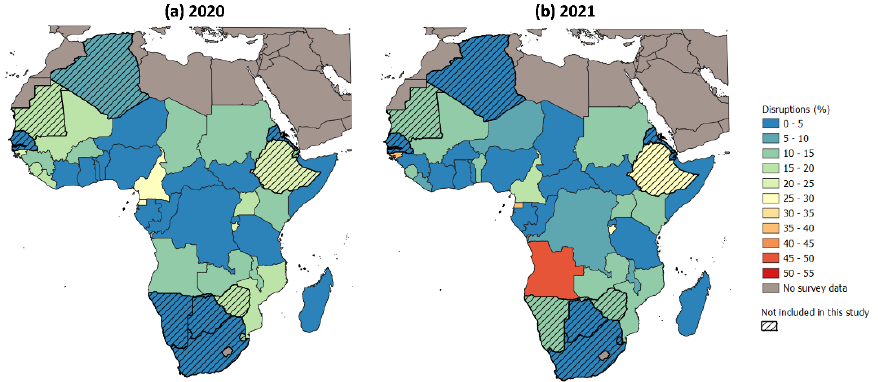
Figure 2. Estimated national-level disruptions in malaria case management in ( a ) 2020 and ( b ) 2021. Table 1. Number of countries in the study region reporting disruptions within the specified magni- tude brackets.